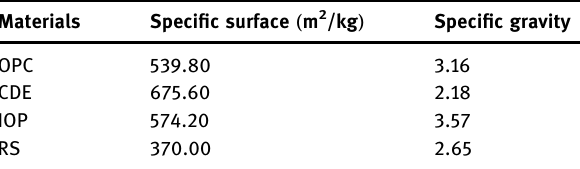
Table 1: Speci fi c surface and speci fi c gravity of materials Materials Speci fi c surface ( m 2 /kg )